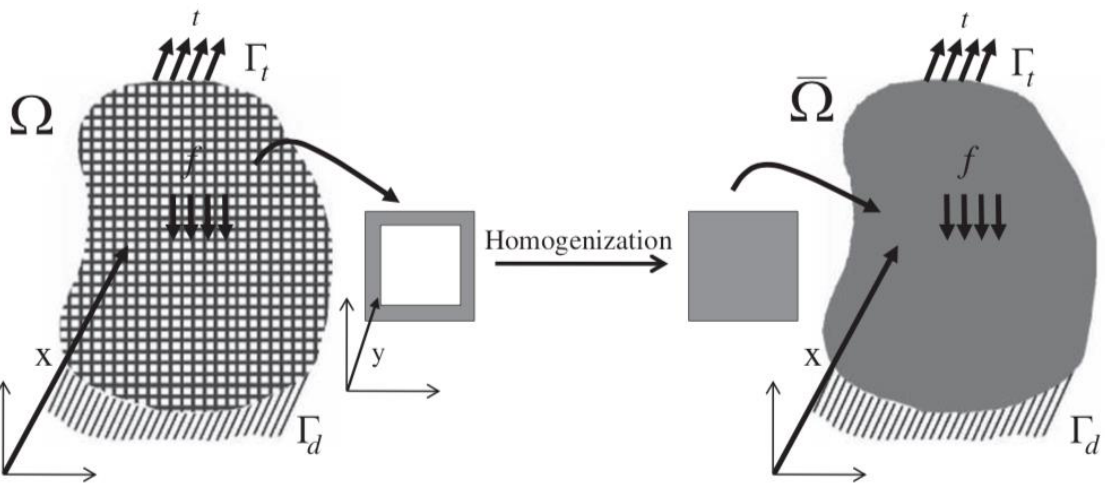
Figure 5. Homogenization concept of a cellular material [12] .